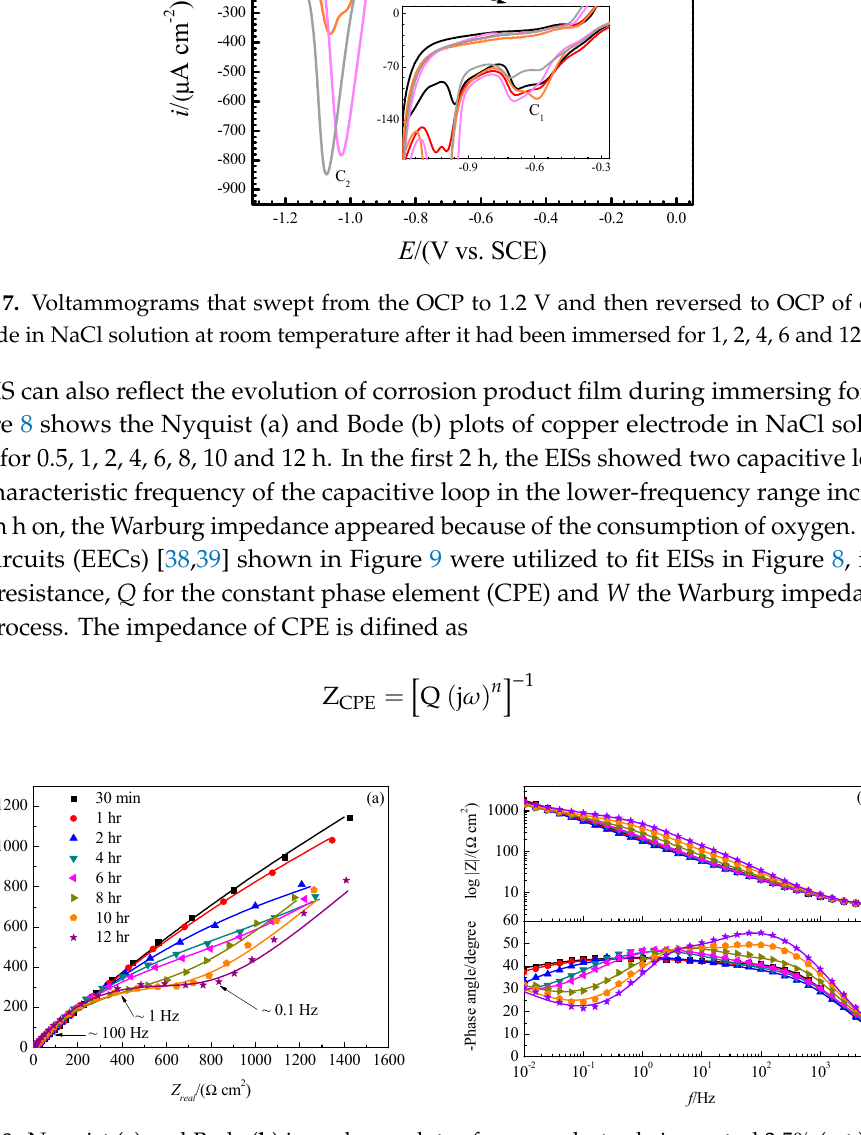
solution at room temperature after immersion for 0.5, 1, 2, 4, 6, 8, 10 and 12 Figure 8. Nyquist ( a ) and Bode ( b ) impedance plots of copper electrode in neutral 3.5% (wt.) NaCl